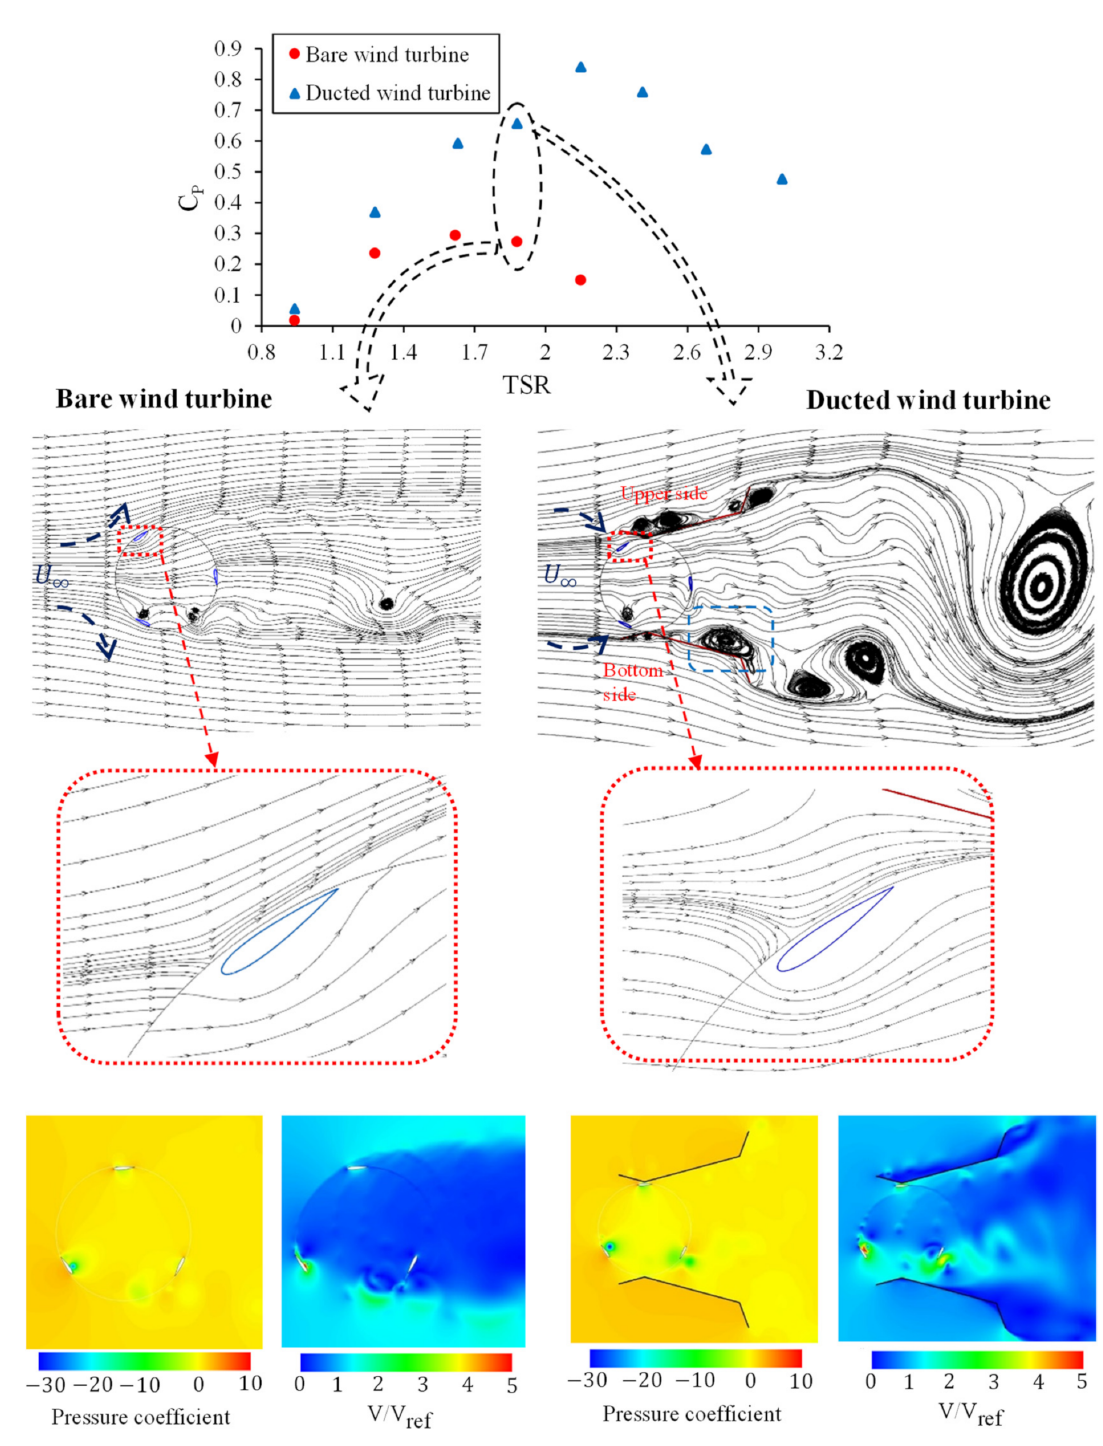
Figure 4. Performance of ducted wind turbine vs. bare wind turbine. The inlet streamlines around the blades were platted at an azimuth angle of 30 degrees. The streamlines showed that the nozzle converged the input freestream flow and enhanced the incident velocity on each blade; the width of the stream-tube at the throat was decreased compared to that at the inlet. It was shown that the throat cross-section velocity was increased by 1.97 times when the duct was used. The dimensionless velocity and pressure coefficient contours for the ducted turbine and the bare turbine are shown in Figure 4.